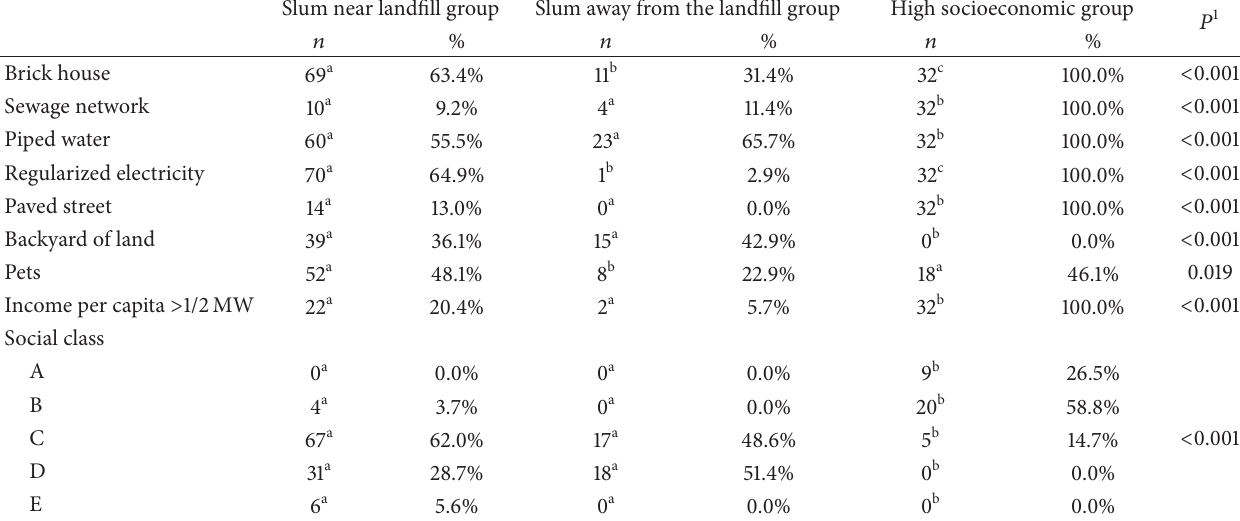
Table 1: Socioeconomic and environmental conditions of children living in the three distinct areas.